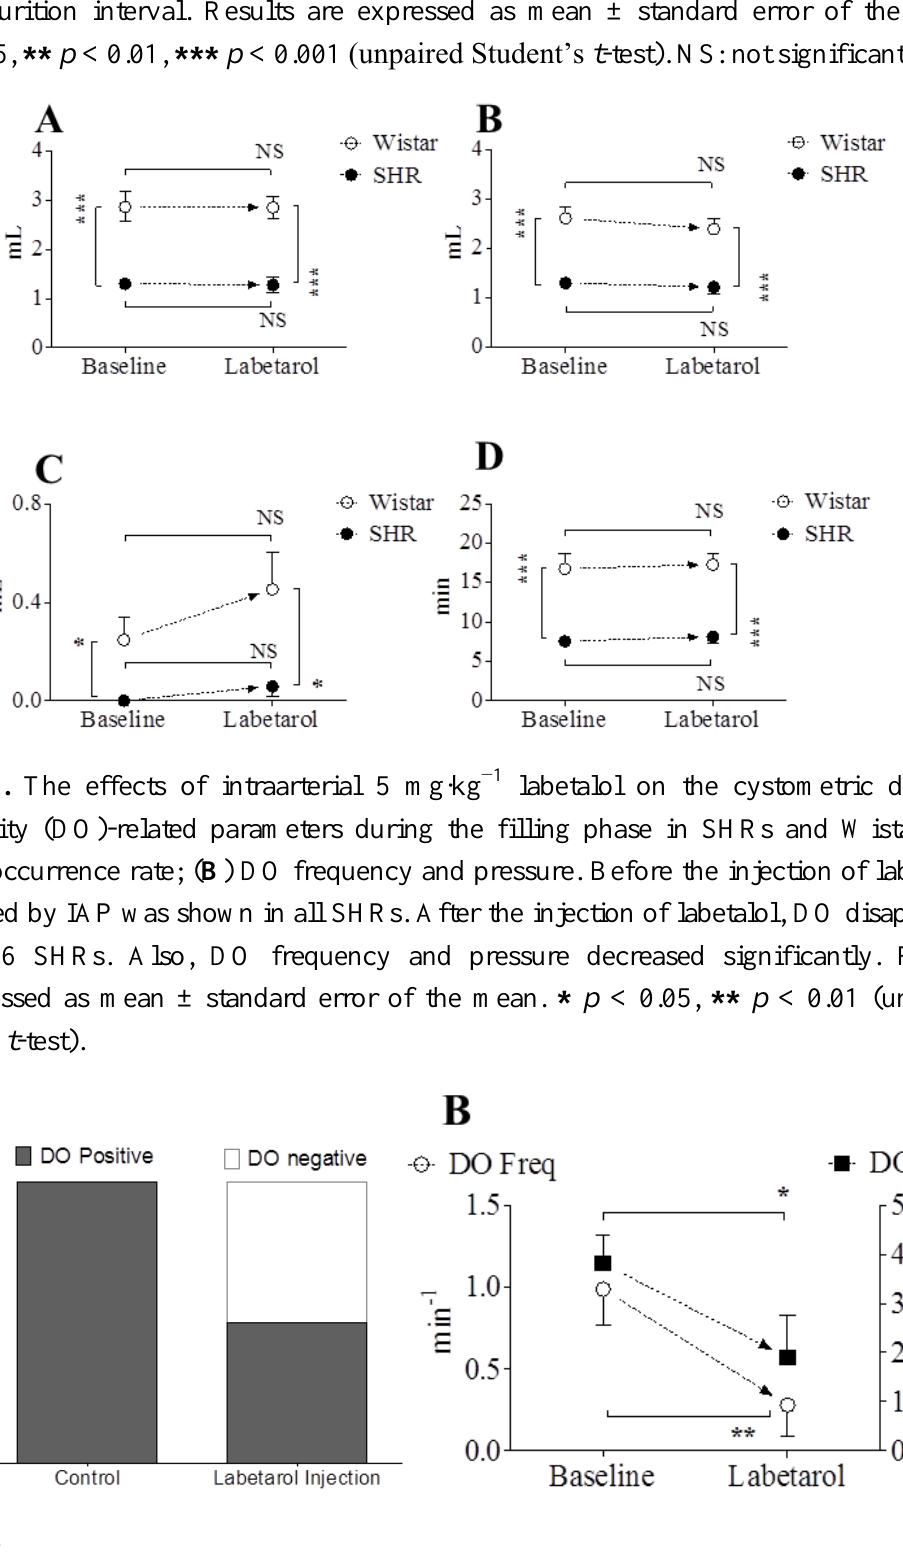
Figure 5. The effects of intraarterial 5 mg·kg −1 labetalol on the volume parameters in SHRs and Wistar rats. ( A ) Bladder capacity; ( B ) Micturition volume; ( C ) Residual volume; ( D ) Micturition interval. Results are expressed as mean ± standard error of the mean.